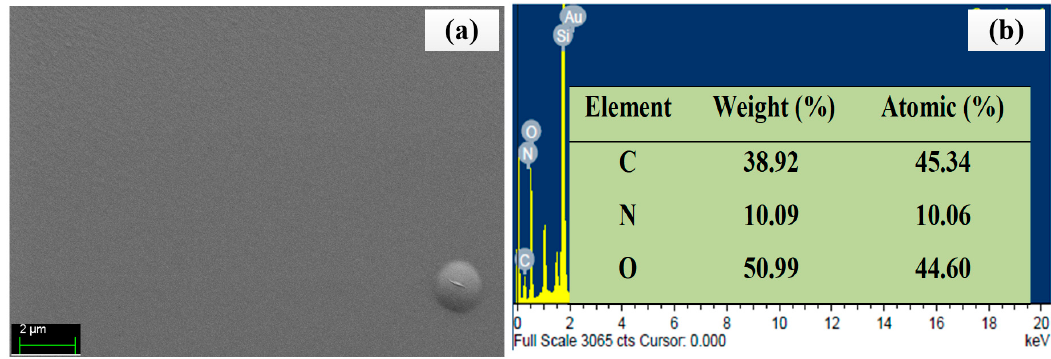
Figure 3. UV-VIS absorption and transmittance spectra of chitosan-PEG blend.